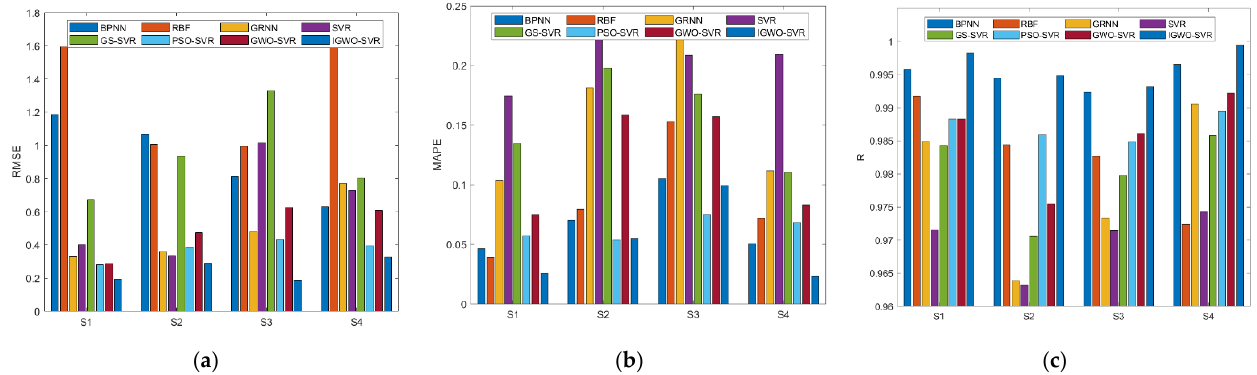
Figure 6. The estimation effect comparison of four subjects under different estimation regression models at the joint angle of 90. ( a ) The comparison of the RMSE index. ( b ) The comparison of the MAPE index. ( c ) The comparison of the R index.